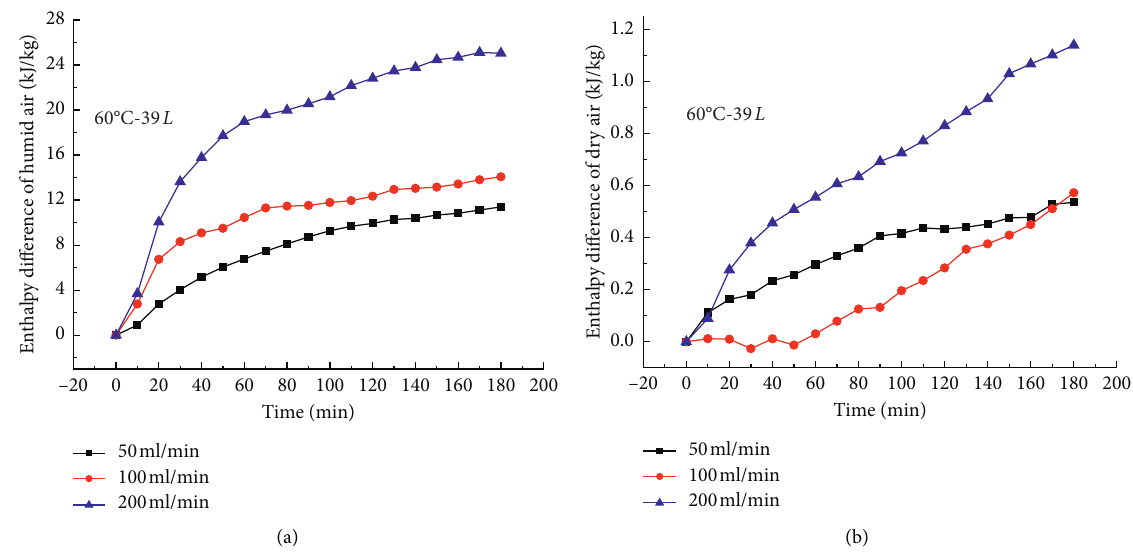
Figure 13: Curves of enthalpy difference variations at different flow rates under the condition of 60 °